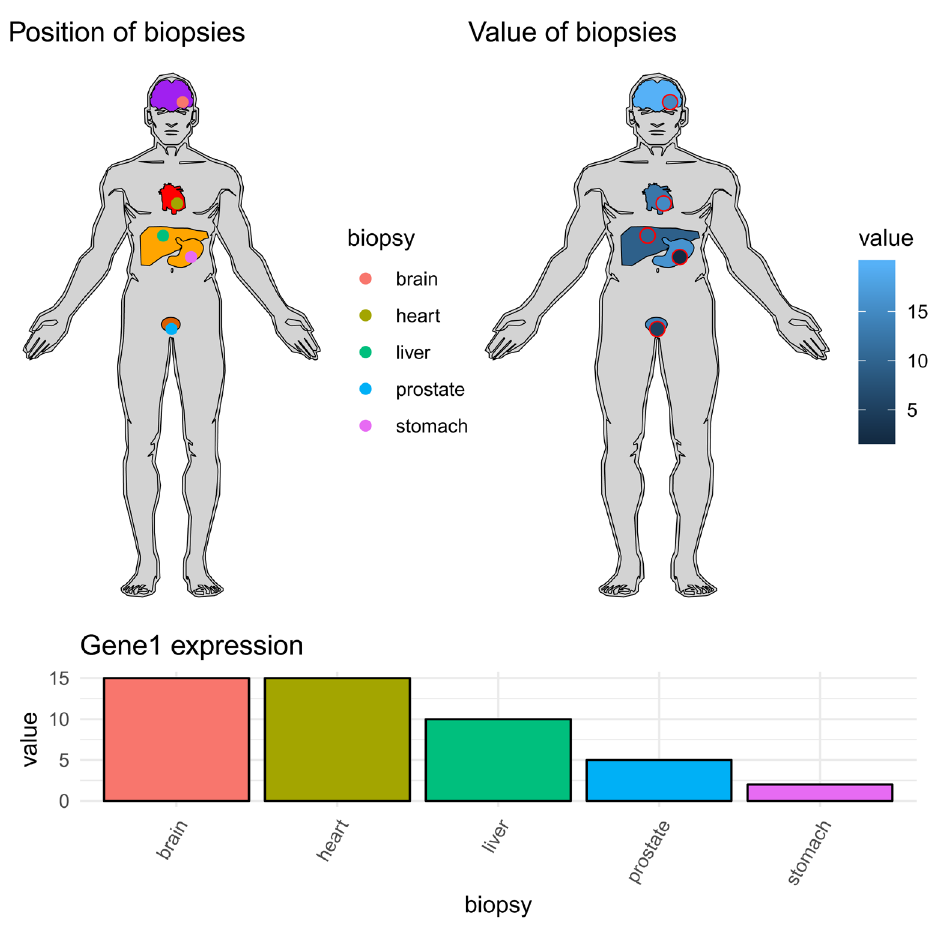
Figure 7. Geom points added to a gganatogram to show the location of tissue biopsies (top left) along with a barplot of biopsy expression for an example gene (bottom). Another option is to fill both tissues and points by value (top right). Red colour around plot added for